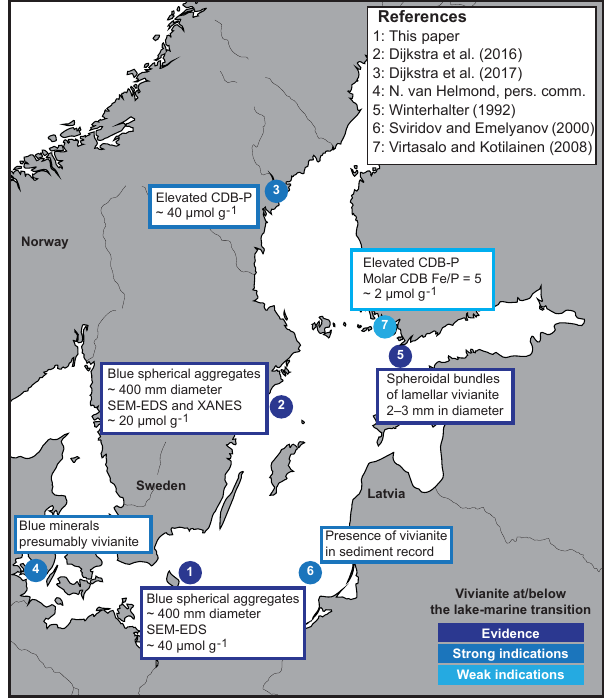
Figure 13. Locations in the Baltic Sea where vivianite is or might be present at or below the lake–marine transition from Ancylus Lake sediments to Littorina Sea sediments (see Sect. 4.4 for further expla- nation). Phosphorus (P) forms that dissolve in a citrate–dithionite– bicarbonate extraction (CDB-P) are generally assumed to represent iron-bound P